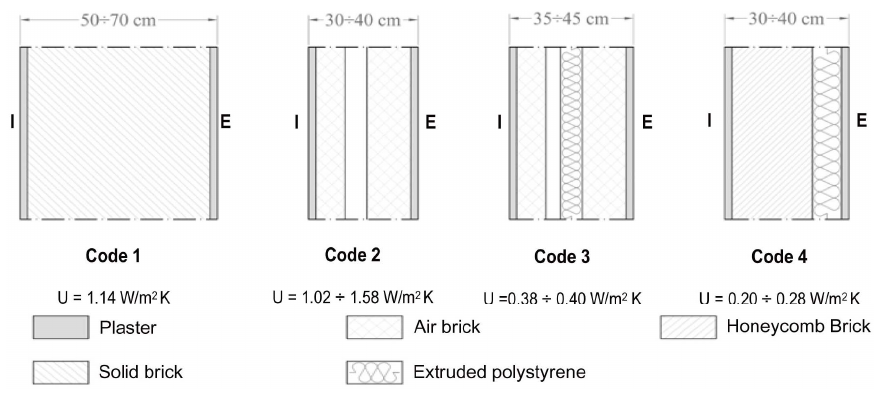
Figure 5. Construction details of the external